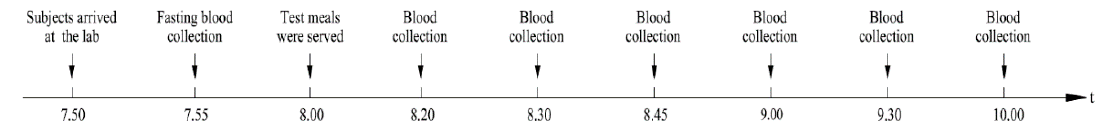
Figure 1. Glycemic response test flow.